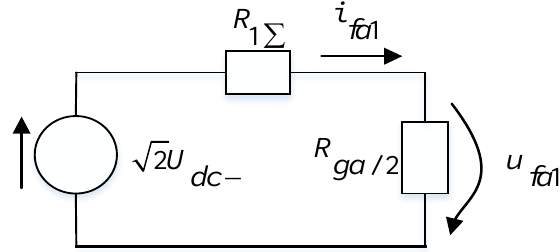
Figure 13. Sequence network connection for pole-pole fault.